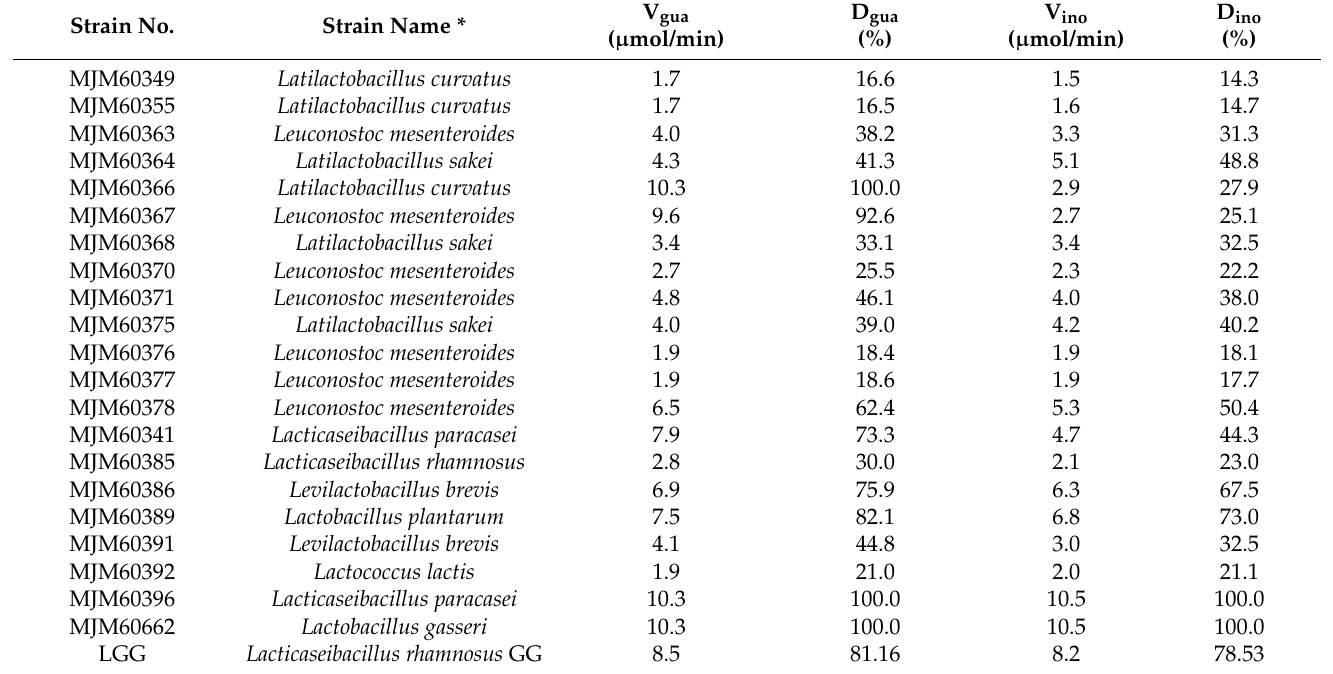
Table 2. Assimilation of nucleoside by candidate